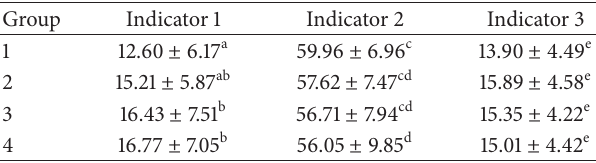
Table 4: Mean, standard deviation, and comparison between molar rotation indicators in the four Class II malocclusion